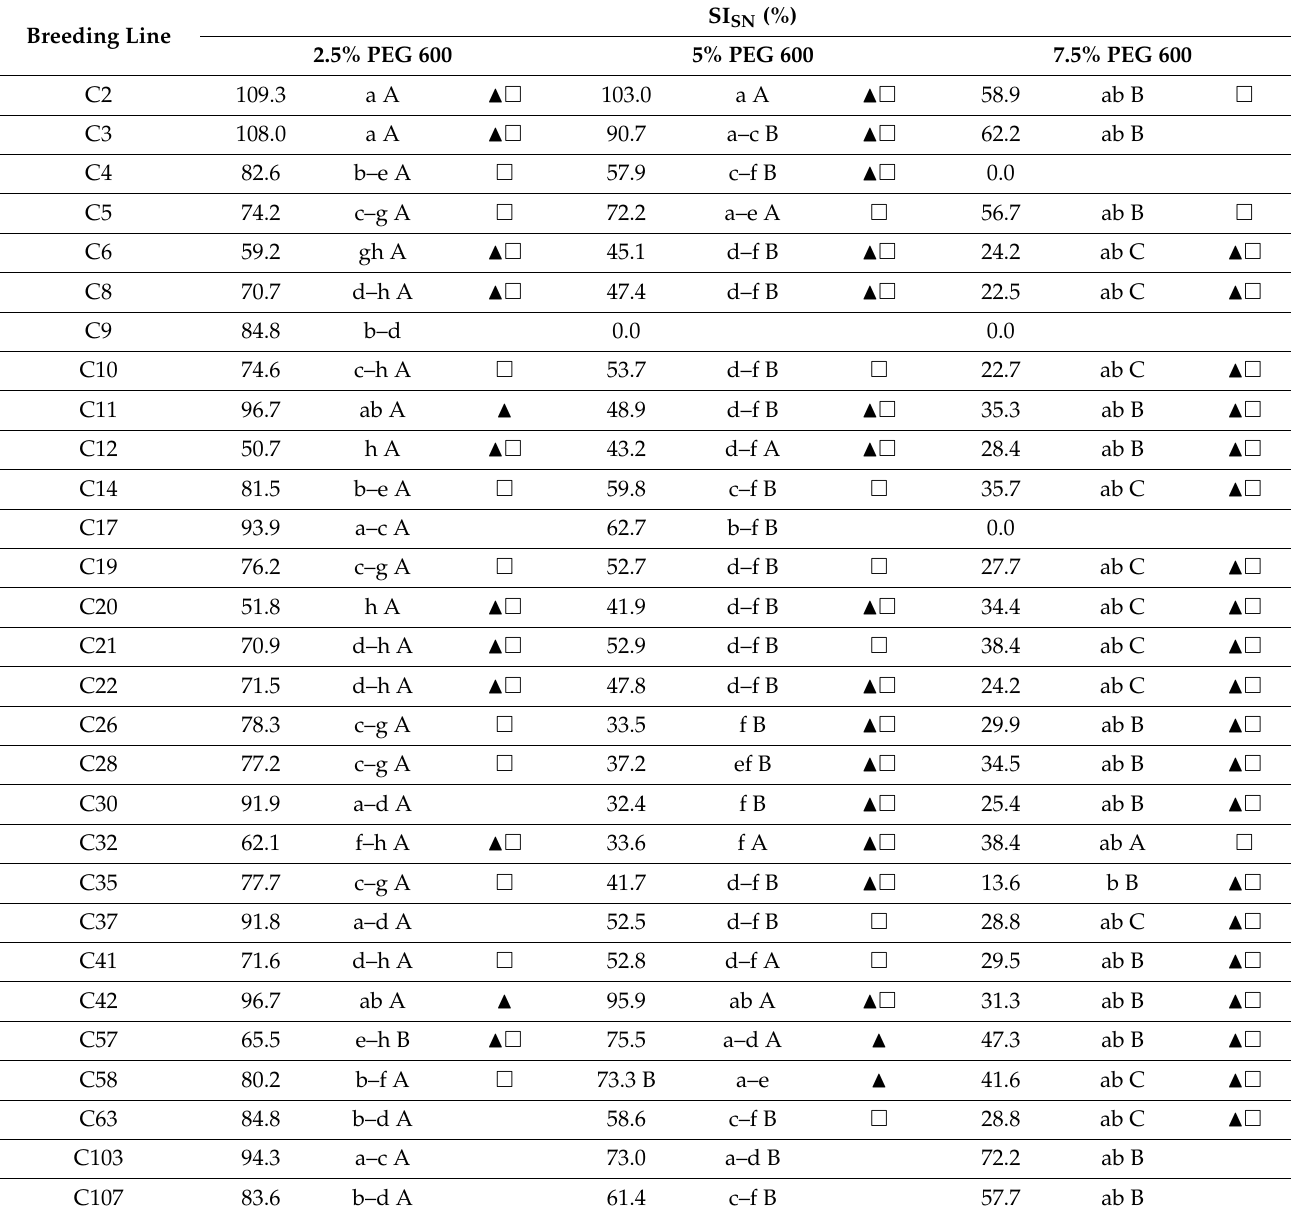
Table 9. Root number SI (SI RN ) values of potato genotypes under osmotic stress induced by PEG 600 added to the medium at levels of 2.5%, 5.0%, and